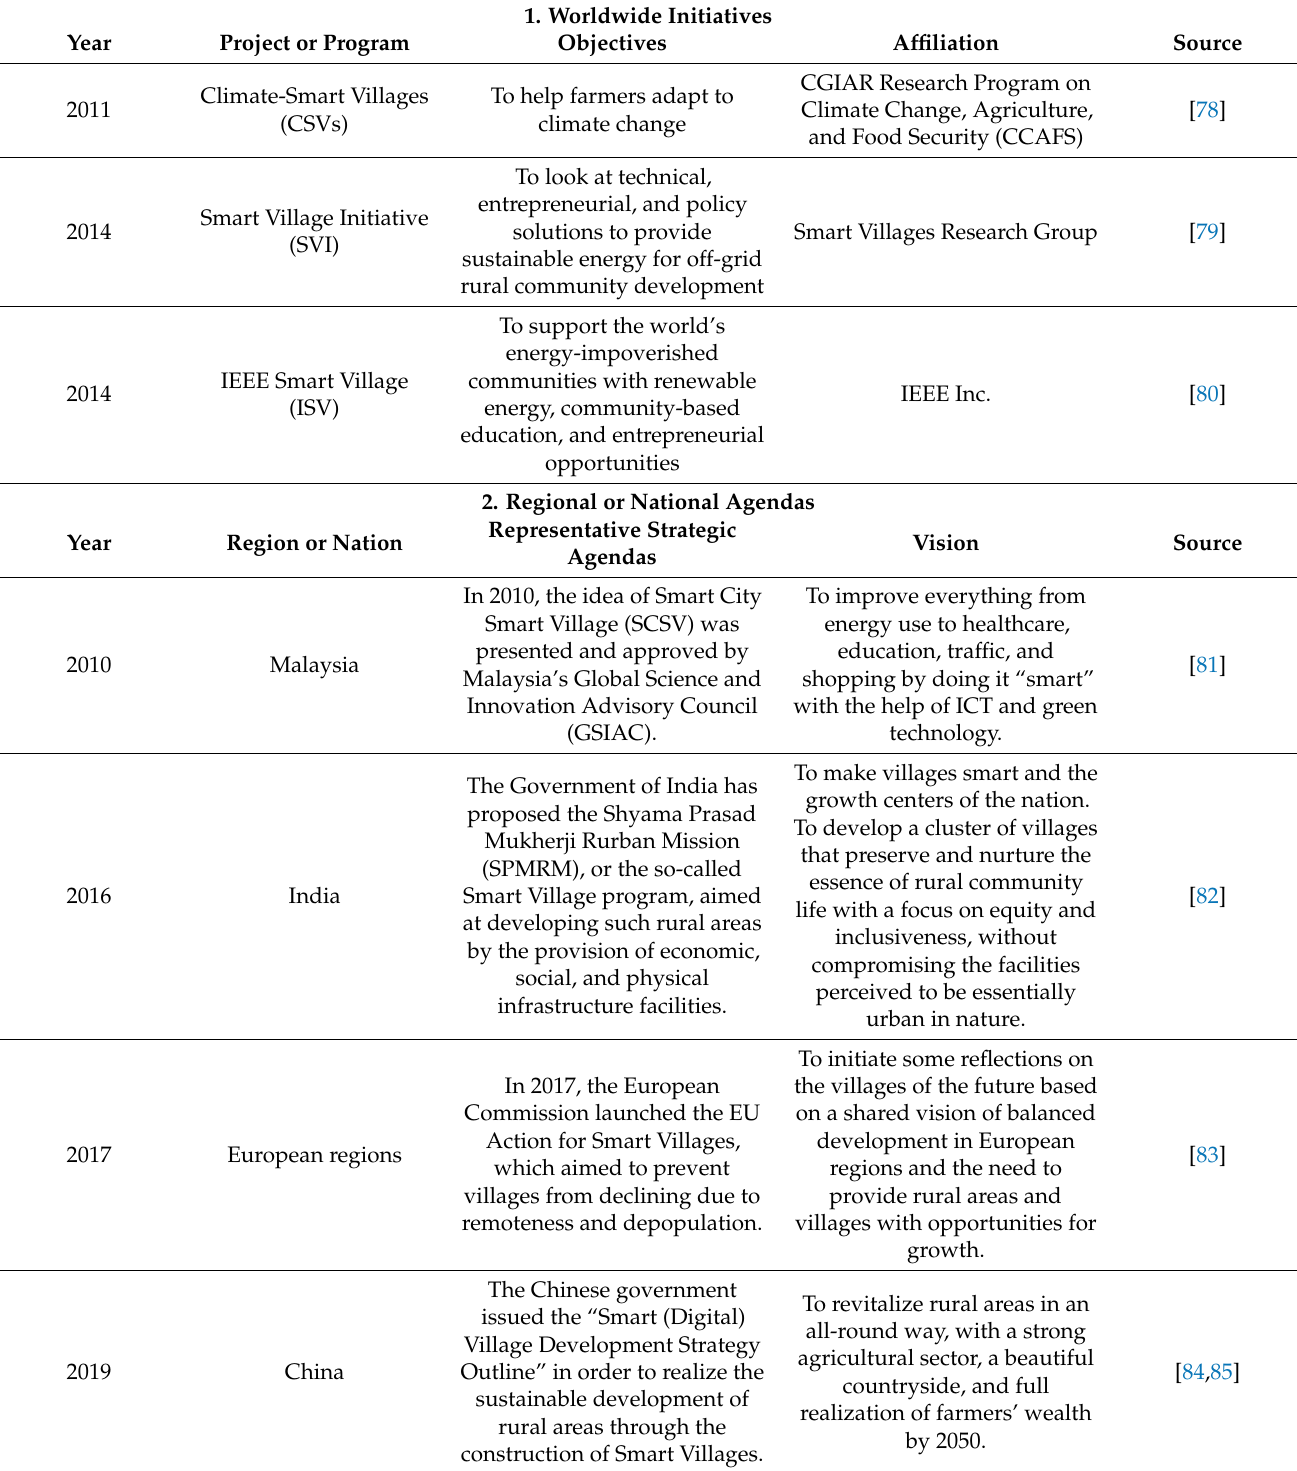
Table 1. Current global initiatives and regional or national agendas related to smart villages. 1. Worldwide